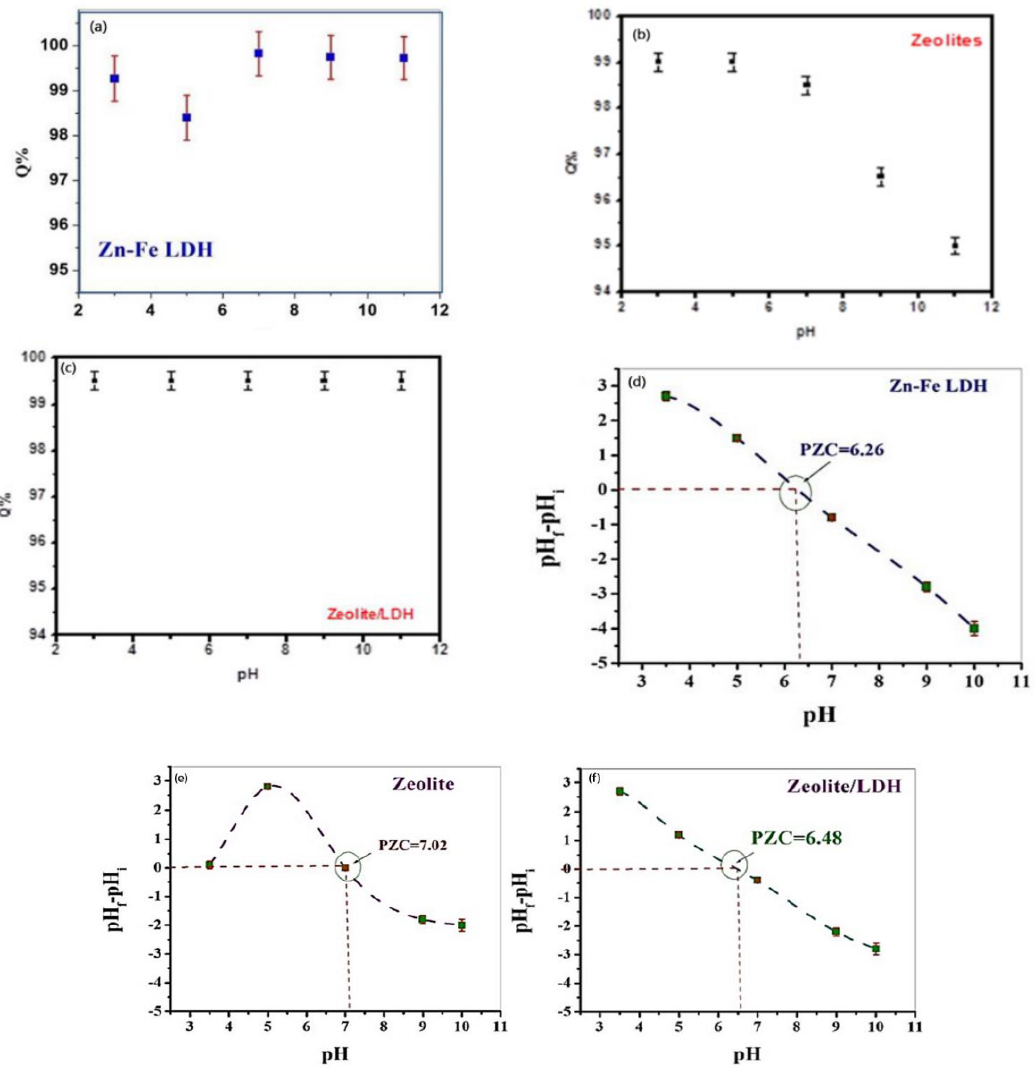
Figure 7. The effect of pH on the adsorption of MB using Zn-Fe LDH ( a ) zeolite ( b ), zeolite/LDH nanocomposite ( c ). and pH PZC values of Zn-Fe LDH ( d ) zeolite ( e ), zeolite/LDH nanocomposite ( f ) at different pH values .